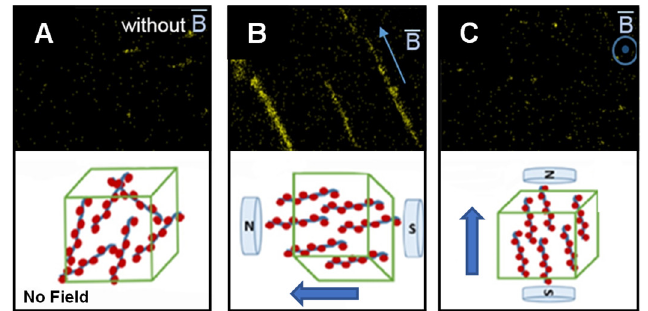
Figure 3. Energy dispersive x-ray images show magnetic cellulose nanocrystals (MGCNC) without ( A ) an applied magnetic field, ( B ) a horizontally aligned magnetic field, and ( C ) a vertically aligned magnetic field. Insets diagrammatically show the field alignment for each case. Reprinted with permission from [113]. Copyright 2011 American Chemical Society.